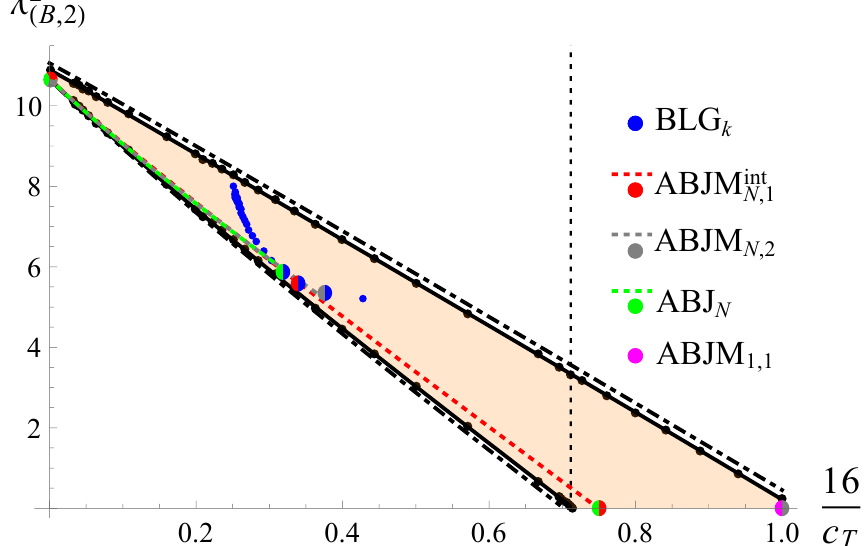
Figure 1 . Upper and lower bounds on the (cid:21) 2 OPE coe(cid:14)cient in terms of the stress-tensor ( B; 2) coe(cid:14)cient c T , where the orange shaded region are allowed, and the plot ranges from the generalized free (cid:12)eld theory limit c T ! 1 to the free theory c T = 16. The blue dots denote the exact values in table 4 in BLG k for k (cid:21) 1. The magenta dot denotes the free ABJM 1 ; 1 theory, the gray and green dots denote the exact values in table 4 for ABJM N; 2 and ABJ N , respectively, for N = 1 ; 2 ; 1 , and the red dots denote ABJM int for N = 2 ; 3 ; 1 . The red, gray, and green dotted lines show the large N; 1 N formulae (3.28) and (B.1) for these theories for all N (cid:21) 2. The black dotted line denotes the numerical point 16 (cid:25) : 71 above which (cid:21) 2 = 0. The solid lines were computed with (cid:3) = 43. To ( B; 2) c T show the level of convergence, the dashed lines are upper and lower bounds that were computed with (cid:3) =